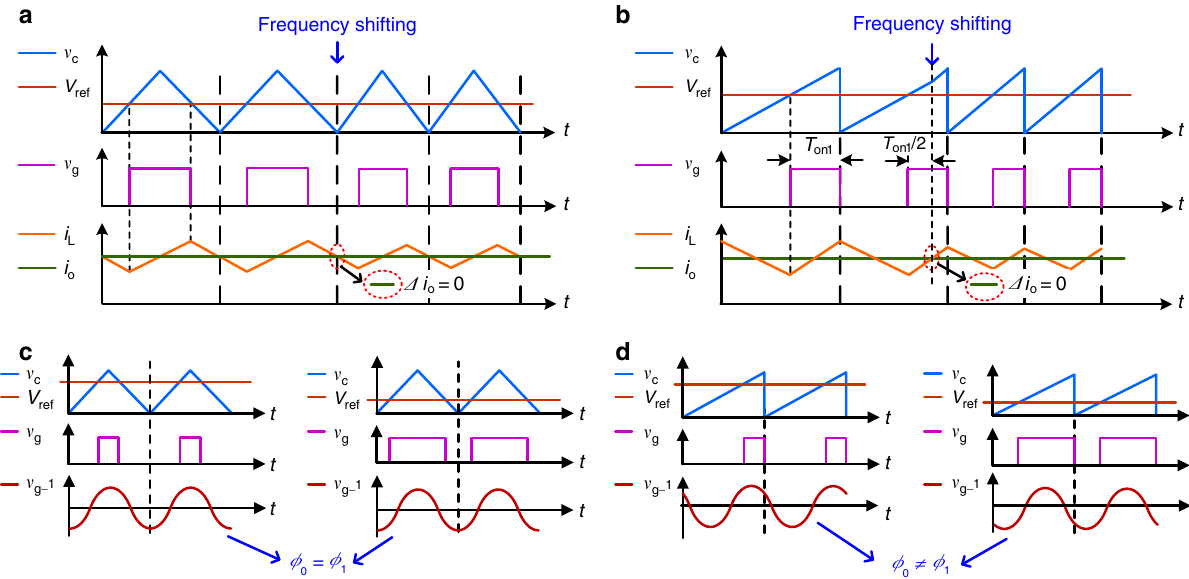
Fig. 4 Comparison of two different carriers of a triangle wave and a sawtooth wave. a A triangle wave sequence is adopted to generate the PWM sequence. The top waveforms, v C and V ref , are the triangle wave and the dc reference signal, respectively. The middle waveform, v g , is the generated PWM sequence, i.e., the gate signal. The bottom waveforms, i L and i o , are the inductor and output currents, respectively. At the moment of the frequency shift at the peak of the triangle wave, the output current remains stable ( Δ i o = 0). b A sawtooth wave sequence is adopted to generate the PWM sequence. The top waveforms, v C and V ref , are the sawtooth wave and the dc reference signal, respectively. The middle waveform, v g , is the generated PWM sequence, i.e. the gate signal. The bottom waveforms, i L and i o , are the inductor and output currents, respectively. At the moment of the frequency shift, the output current remains stable ( Δ i o = 0). The frequency shift occurs on the upward ramp of the sawtooth wave, where the high level of v g lasts for ½ T on1 . c A triangle wave sequence is adopted to generate the PWM sequence. The top waveforms, v C and V ref , are the triangle wave and the dc reference signal, respectively. The middle waveform, v g , is the generated PWM sequence, i.e. the gate signal. The bottom waveform, v g_1 , is the fundamental component of the gate signal. When the duty cycle of the gate signal changes, the phase of v g_1 remains constant. d A sawtooth wave sequence is adopted to generate the PWM sequence. The top waveforms, v C and V ref , are the sawtooth wave and the dc reference signal, respectively. The middle waveform, v g , is the generated PWM sequence, i.e. the gate signal. The bottom waveform, v g_1 , is the fundamental component of the gate signal. Φ 0 and Φ 1 refer to the phase of before and after the duty cycle changes. The phase of v g_1 varies with a change in the duty